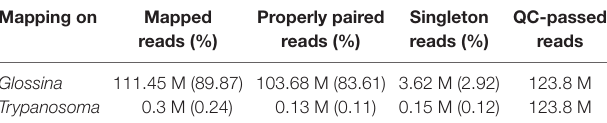
Table 4 | Read mapping